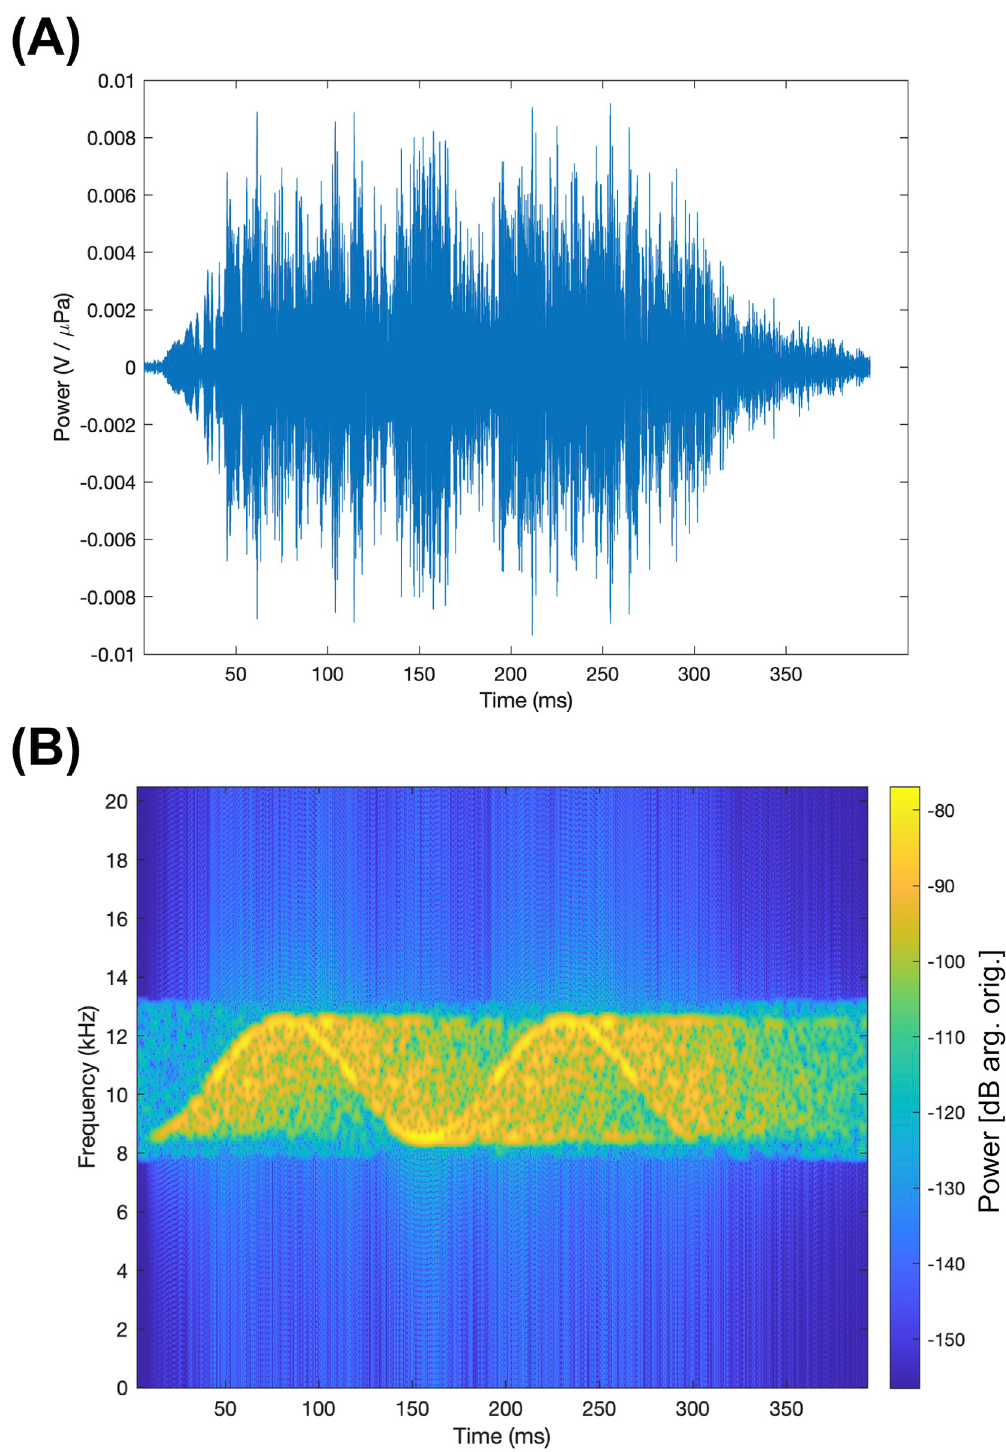
Fig 4. Example of played signal with reverberation. Shown here is real sound data obtained by playing the signal from Fig 3 at Source Location P14 and receiving it at Hydrophone 1. (A) The received signal waveform. Signal amplitude is uncalibrated. (B) The spectrogram of the signal waveform. As above, this is a standard, 1024-bin, Hamming-window spectrogram; sampling is 192 kHz, and frequency resolution of the plot is 187.5 Hz (smoothing added). Color scale is in uncalibrated decibels.